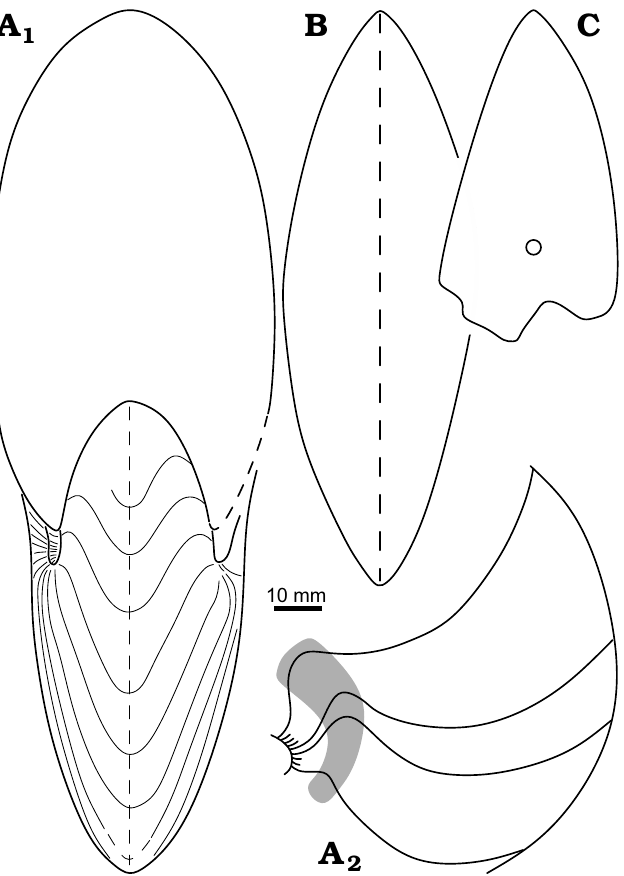
Fig. 5. Cross-sections and external sutures of the hercoglossid nautiloid Angulithes mermeti (Coquand, 1862) from the Cenomanian of Wadi Ghonima, Egypt. A . AFK 225, shell shape in apertural view (A 1 ), exter- nal sutures (A 2 ); grey shading indicates position of the umbilical saddle. B . AFK 202, shell shape in ventral view. C . AFK 218, whorl shape, show- ing the position of the siphuncle.